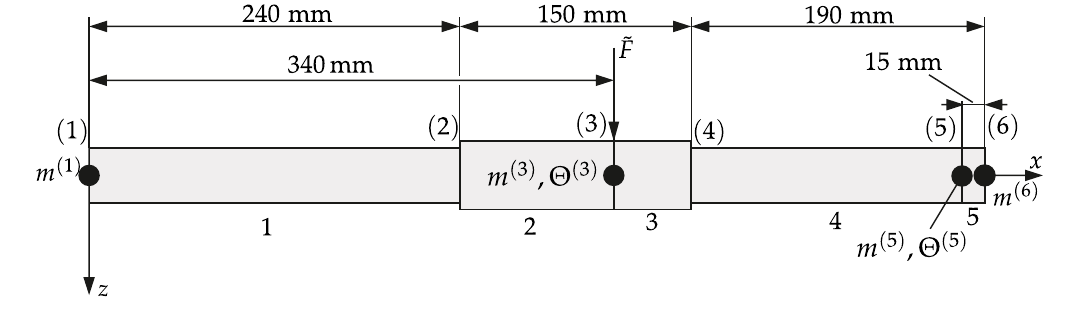
Figure 10. Model of the test object. Table 8. List of the additional components of the test object.